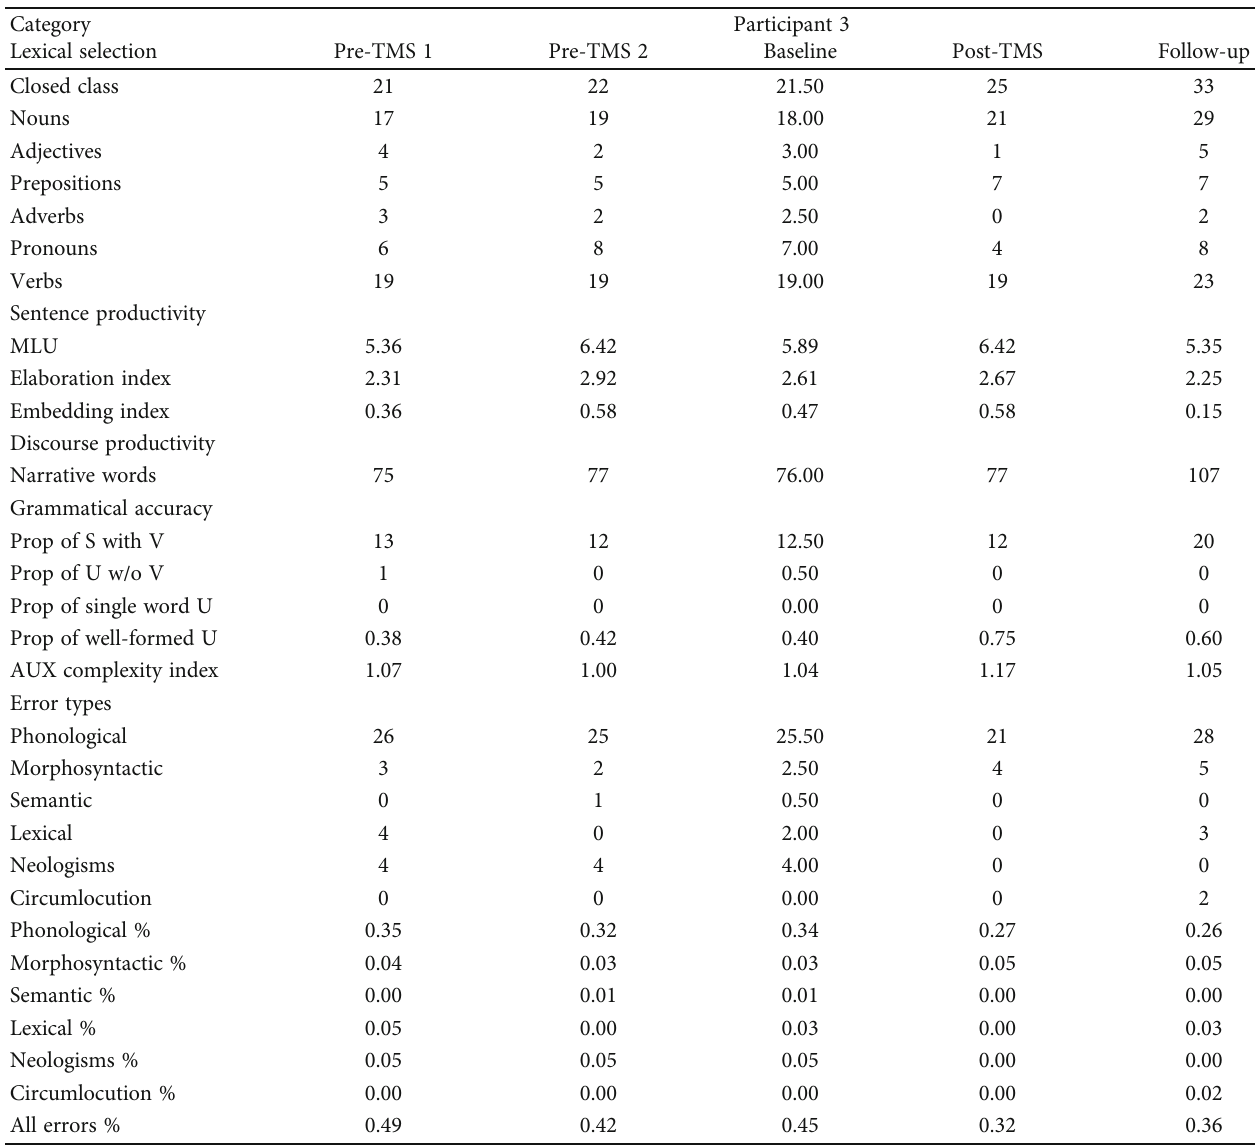
Table 5: Short-term (one day posttreatment) and long-term (two months posttreatment) e ff ects of cTBS on narration outcomes (i.e., functional communication) for participant